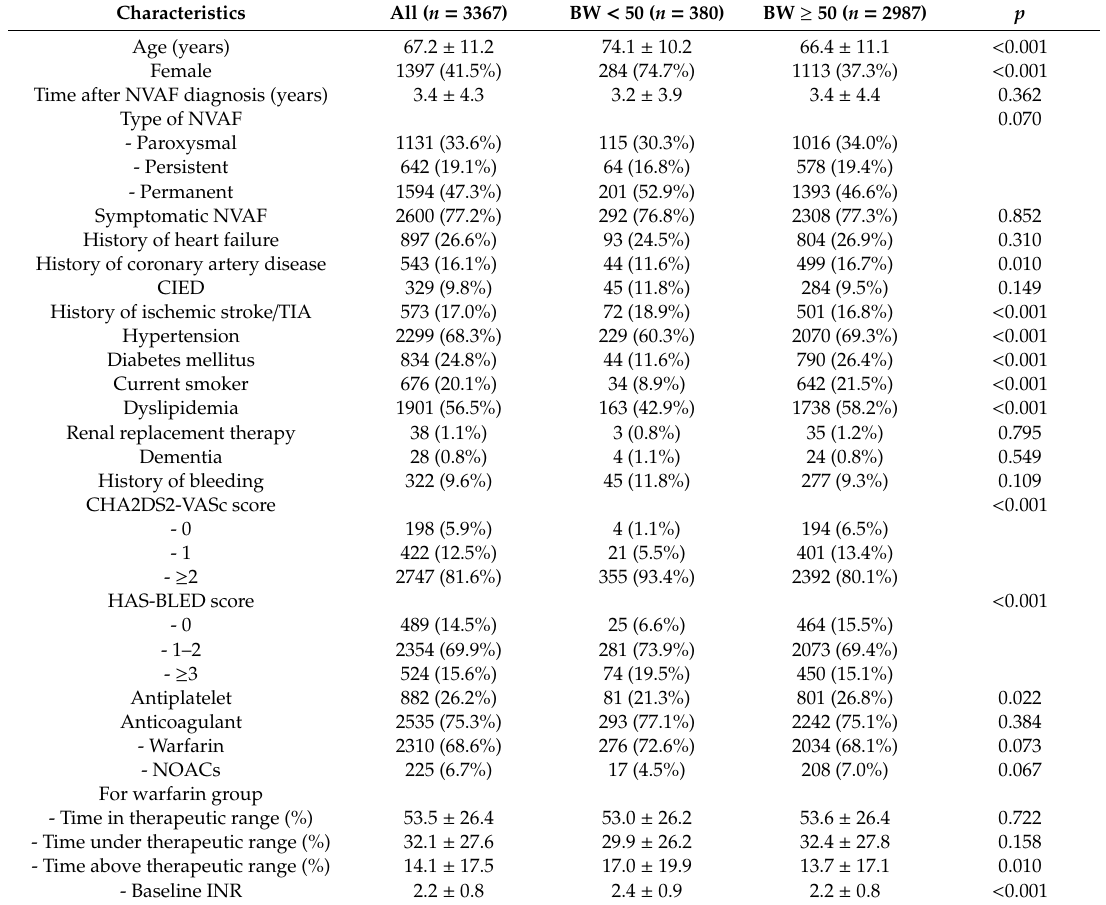
Table 1. Baseline characteristics compared between patients with body weight < 50 and ≥ 50 kg.